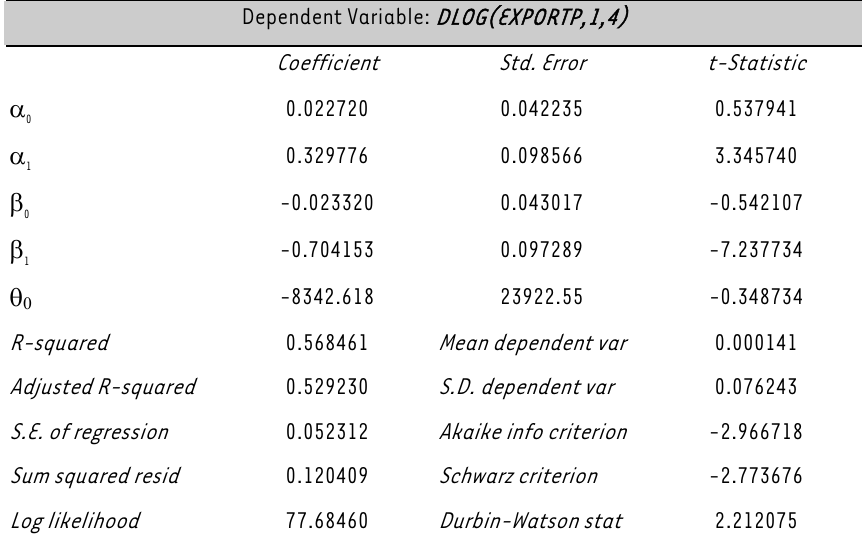
TABLE 8: Results of the ESTAR model for